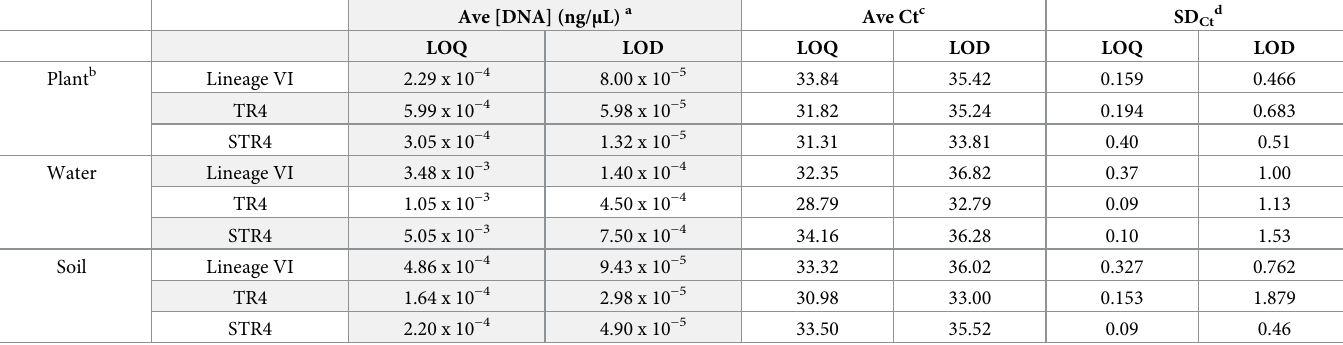
Table 4. Limit of detection and limit of quantification of Fusarium oxysporum f. sp. cubense in plant, water and soil samples.